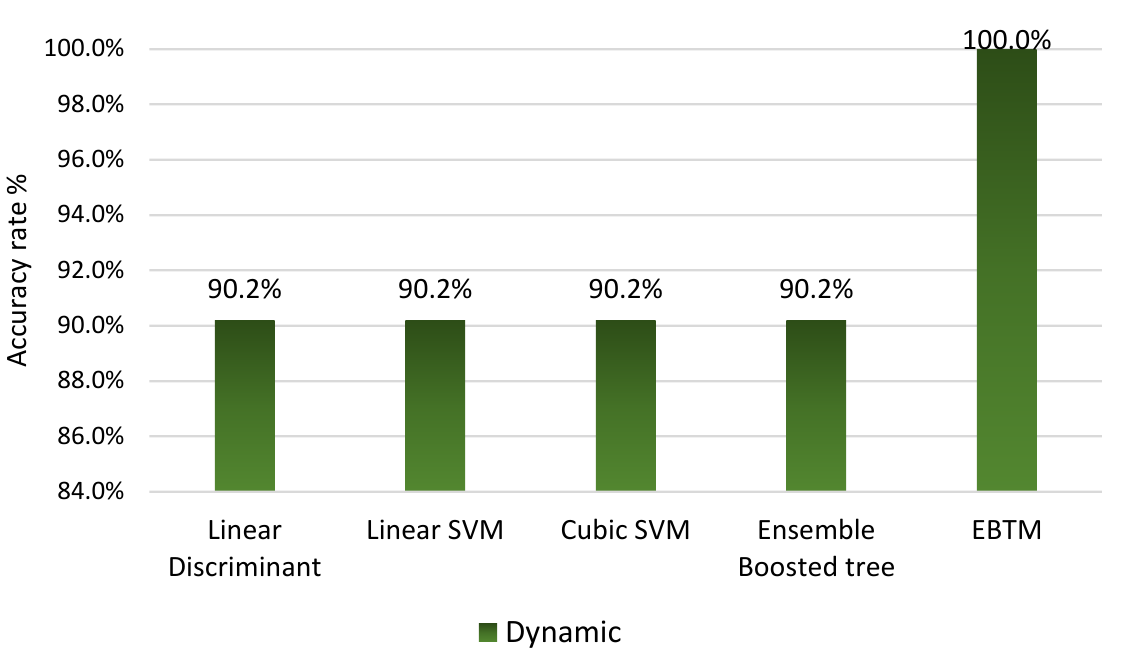
Figure 8. The overall accuracy of the five MLTs used in this research throughout the dynamic operation mode in DN.